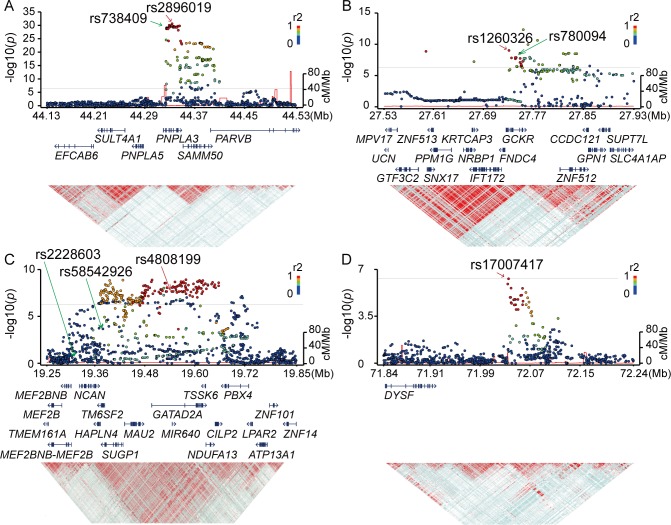
Regional Manhattan plots around the SNP markers showing genome-wide significance in the GWA studies.P-values, gene organization, and linkage disequilibrium (LD) plots according to the chromosomal position of the three significantly genome-wide associated regions for NAFLD (A-C) and the one region for NASH-HCC (D). Each figure spans 200 kb (A, B, and D) or 300 kb (C) in both the 5’ and 3’ directions from the SNP with the strongest association (shown with a red arrow) in the GWA studies. P-values are plotted for both genotyped and imputed SNPs in the upper panels, and previously reported SNPs with genome-wide significance are indicated by green arrows. The colors of the circles representing p-values correspond to the strength of LD (r2) from the most significant SNP in the GWA studies. The brightness of the red color in the LD plots in the lower panels also corresponds to the strength of LD.